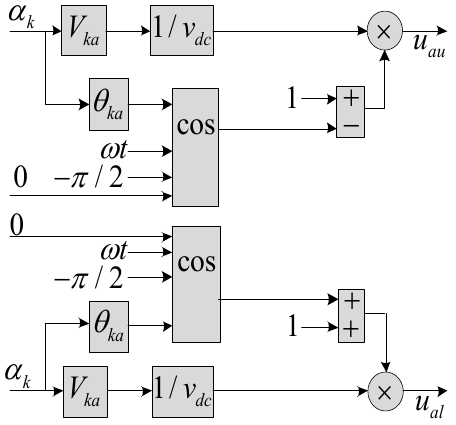
Figure 2. The proposed modulation functions for phase “a”.